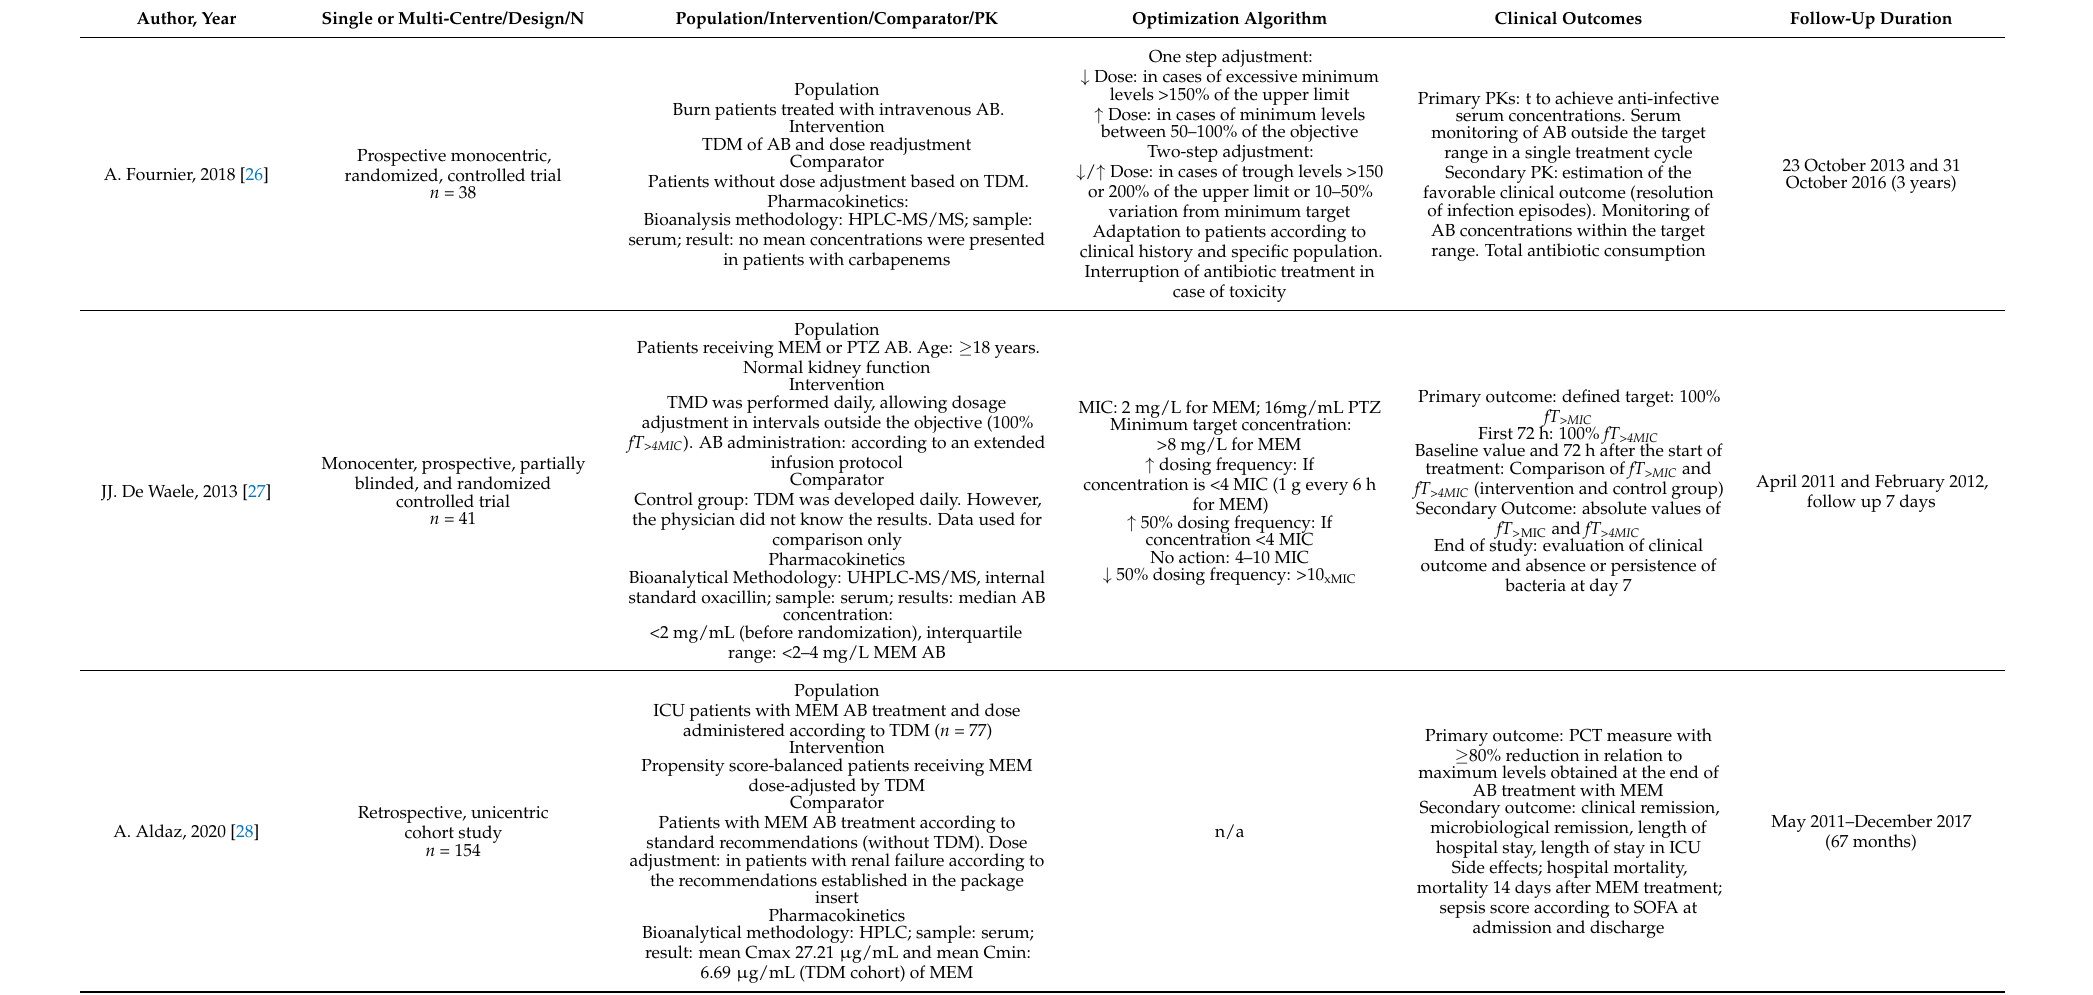
Table 1. Description of studies